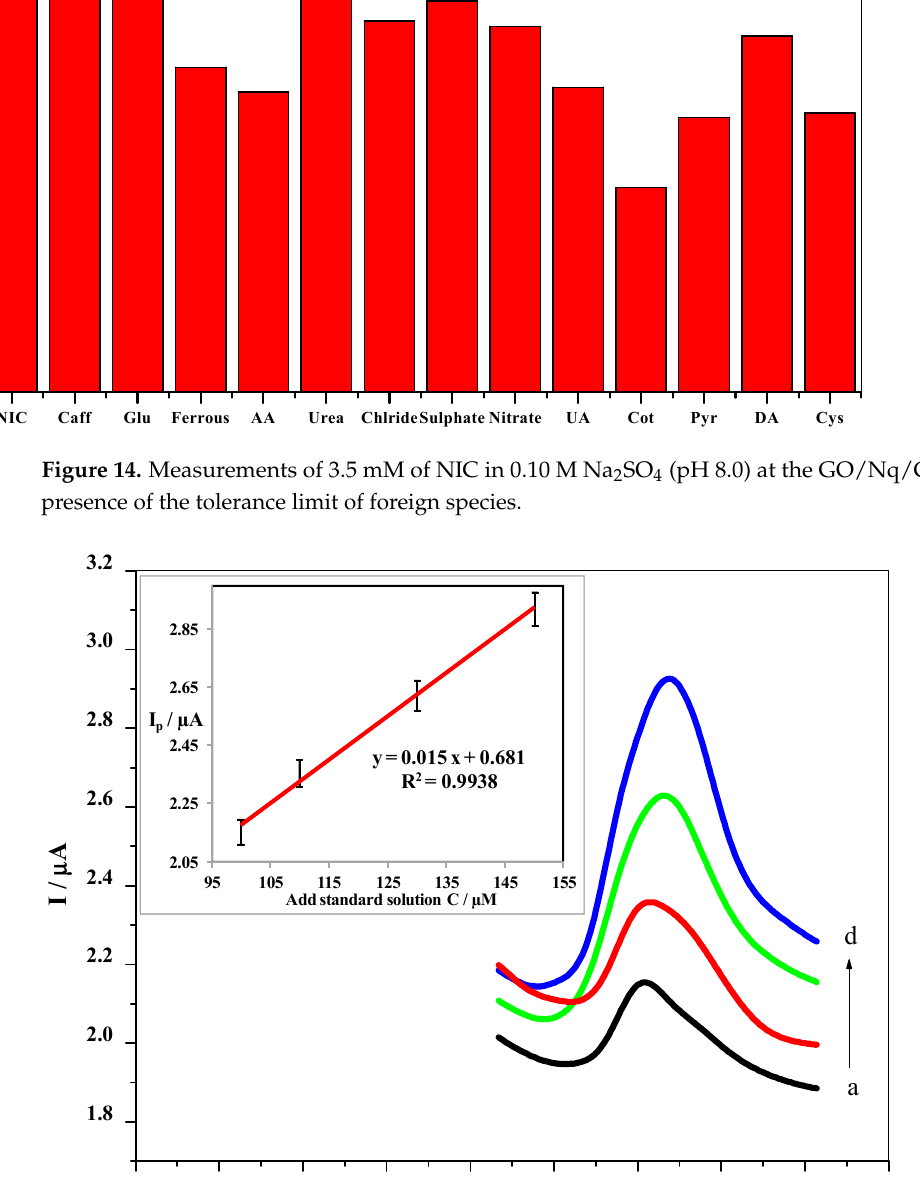
Figure 14. Measurements of 3.5 mM of NIC in 0.10 M Na 2 SO 4 (pH 8.0) at the GO/Nq/GCE in the presence of the tolerance limit of foreign species.